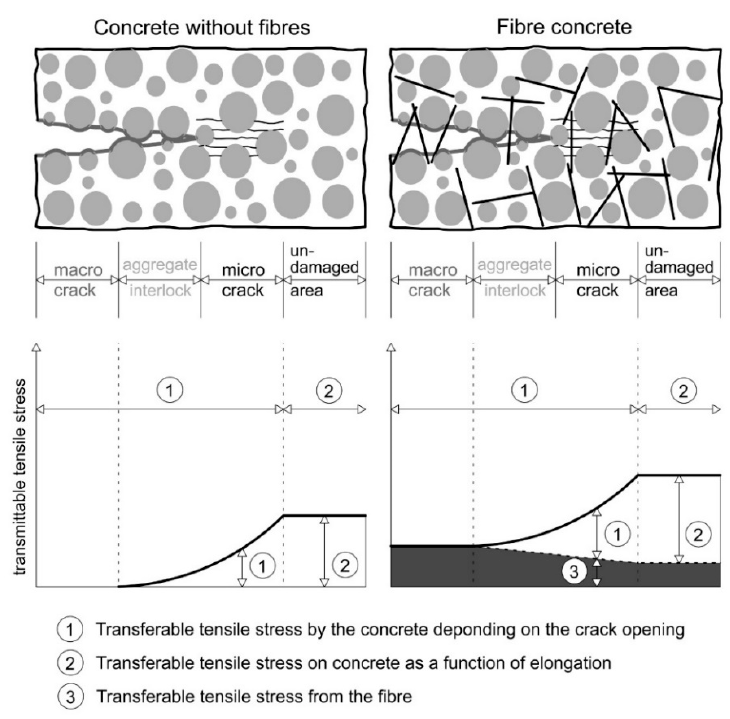
Figure 1. Schematic representation highlighting the fracture mechanical effect of steel fibres in concrete. Functioning of the fibres in the transition from micro to macro cracking (based on [8]).